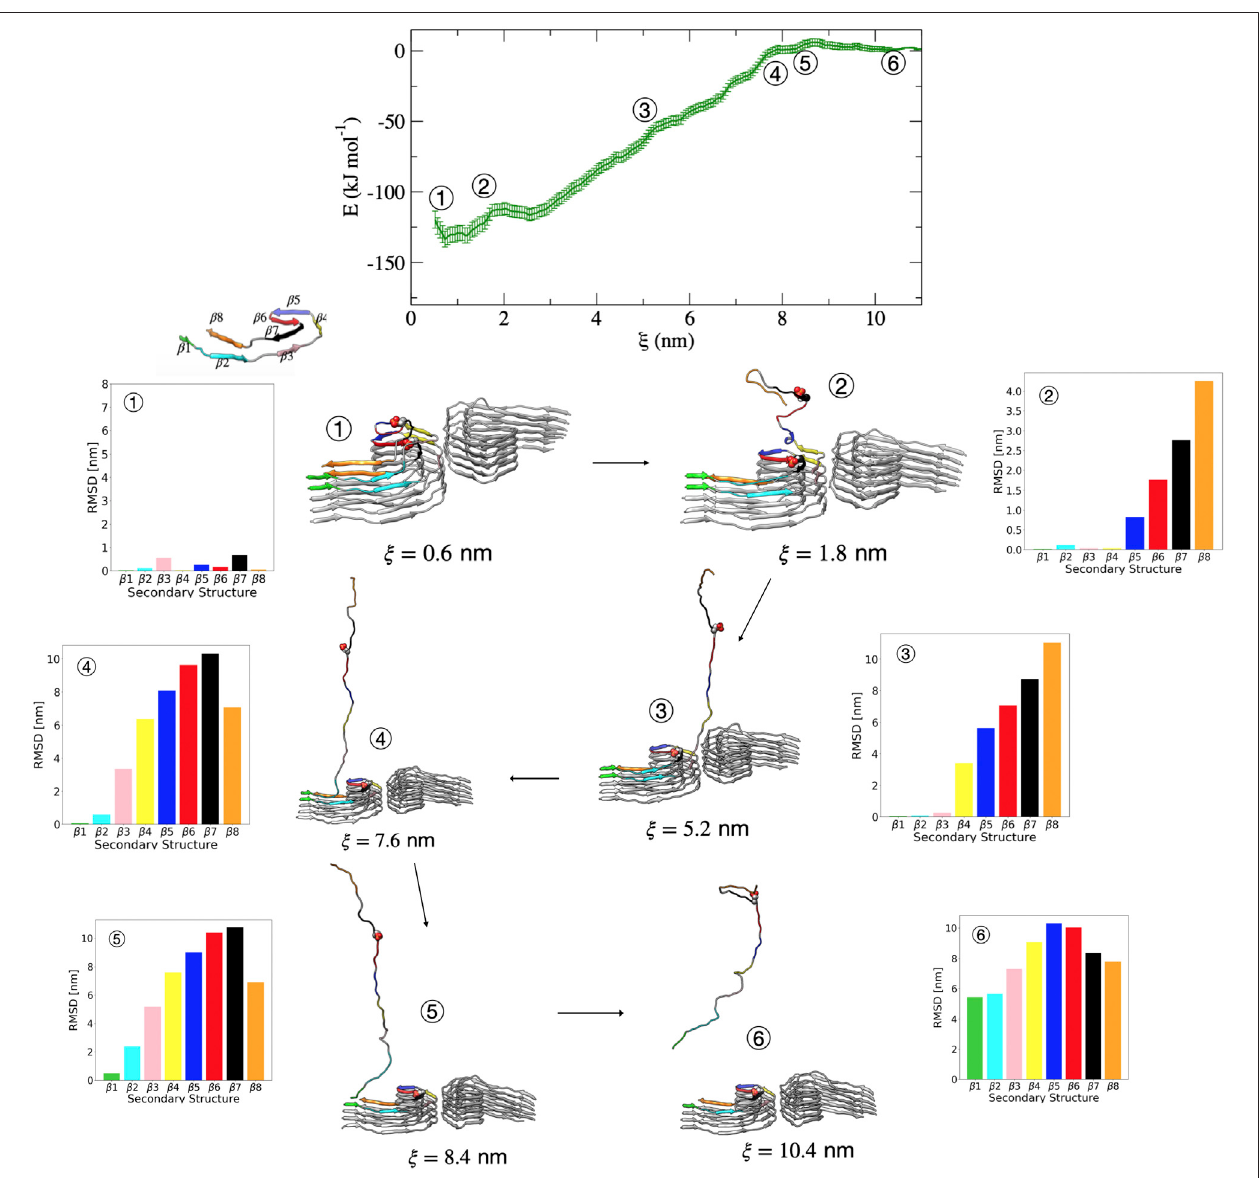
FIGURE 6 | Free energy pro fi le for the association/dissociation of a single pSer356 peptide from the phosphorylated PHF proto fi bril at Ser356. Representative structuresareshownalongwiththedRMSDofthesecondarystructureregions.Betweenstructures1and2,thedRMSDincreasesfor β 5(blue), β 6(red), β 7(black),and β 8(orange).Structure 3showslossofthe β 4(yellow),andstructure 4showslossof β 3(pink).Structure5showslossof β 2(cyan).Thecompletedissociationoccurswith loss of β 1(green)thatincludesthePHF6region.Structures wereobtainedfromumbrellasamplingsimulationwindowwithinthedifferentregionsalongthereaction coordinateafter5 ns.ThedRMSDvaluesineachofthebargraphsarecalculatedfrom Eq.1 forthedepictedrepresentativestructurestakenat5 nsofsimulation,where the fi nal folded state is the reference